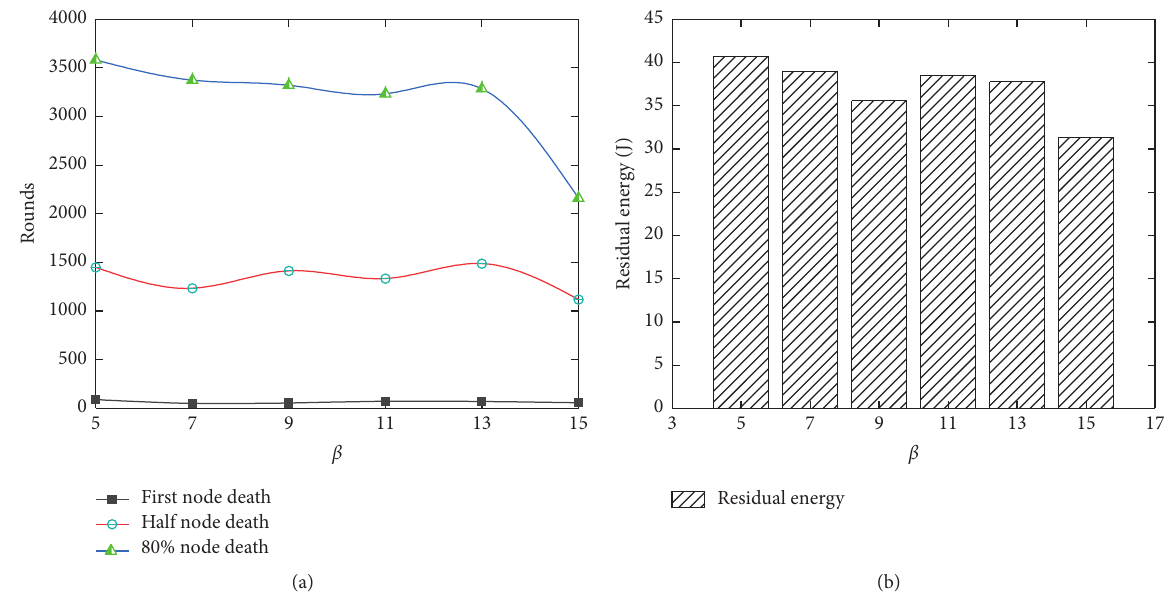
Figure 9: Relevance evaluation between β and assessment metrics: (a) effect of β on death round and (b) effect of β on residual